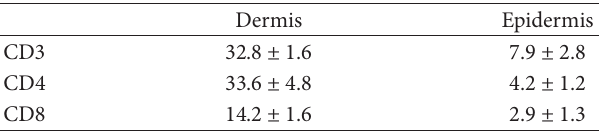
Table 1: T cellular markers identified in human skin lesions of PV patients by immunohistochemistry. The calculated average number of stained cells in three consecutive microscopic fields (250x) is reported.